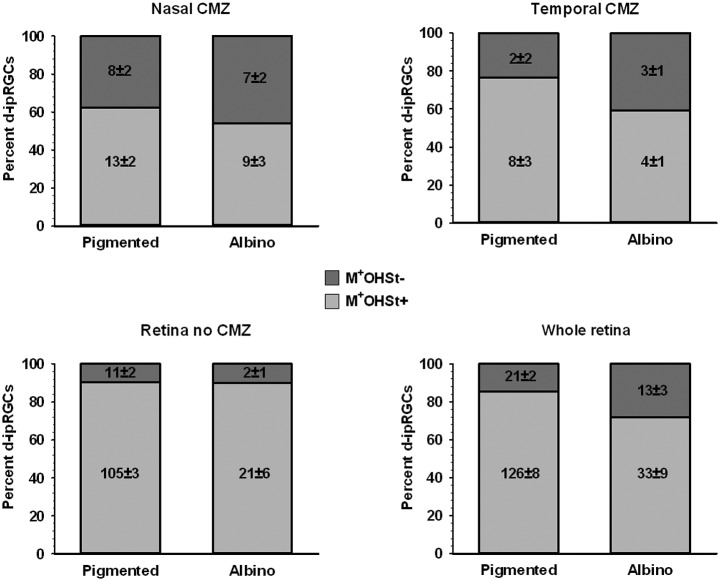
Quantification of d-ipRGCs in the retinae of pigmented and albino mice traced from the ON. Stacked bar graphs showing the total number (mean ± SD) and percentage of M+OHSt+ and M+OHSt− d-ipRGCs in different regions of the pigmented and albino retina. Note that a relatively high percentage of d-ipRGCs in the CMZ are OHSt− (top graphs) and that approximately half of the M+OHSt− d-ipRGCs in pigmented mice are found in CMZ, while the majority of M+OHSt− d-ipRGCs are located outside the CMZ in the albino retina (compare bottom two graphs).